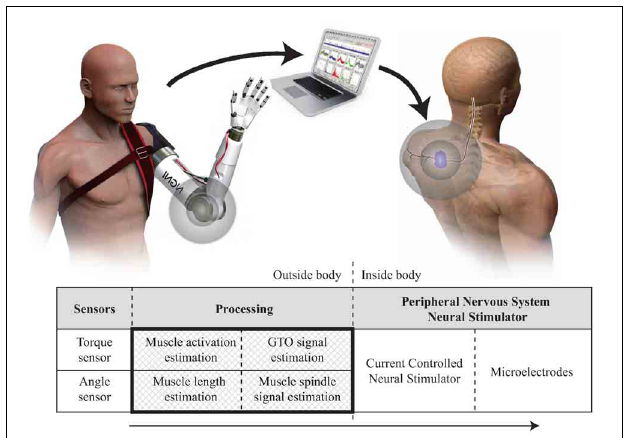
FIGURE 1 | Proprioceptive prosthesis concept. Crosshatched area indicates the part of the system presented here.